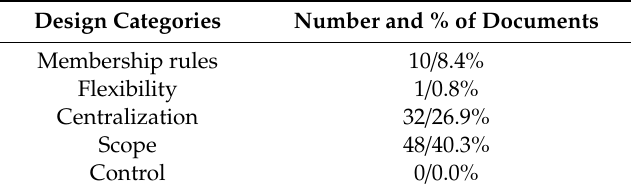
Table 3. Prevalence of design categories in